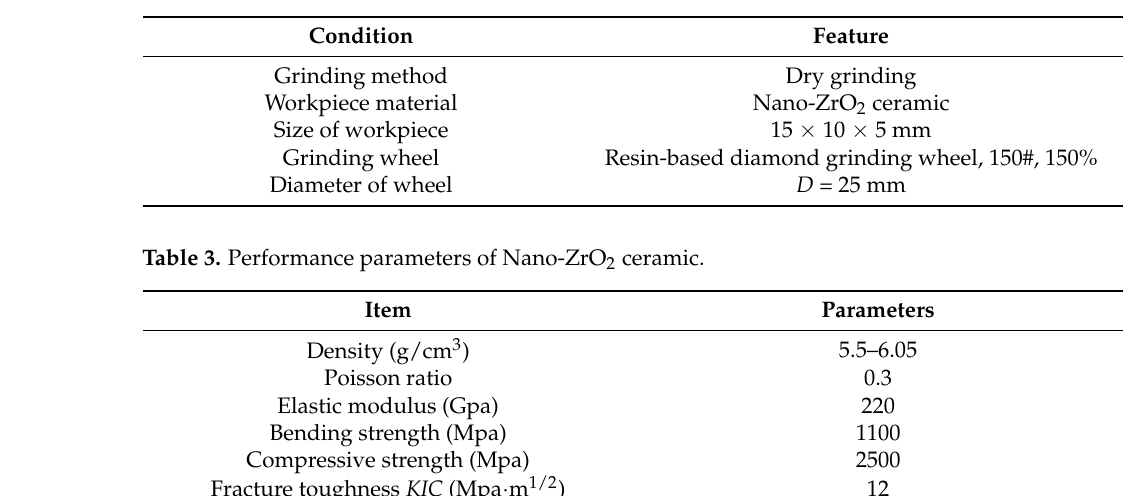
Table 2. Experimental conditions.